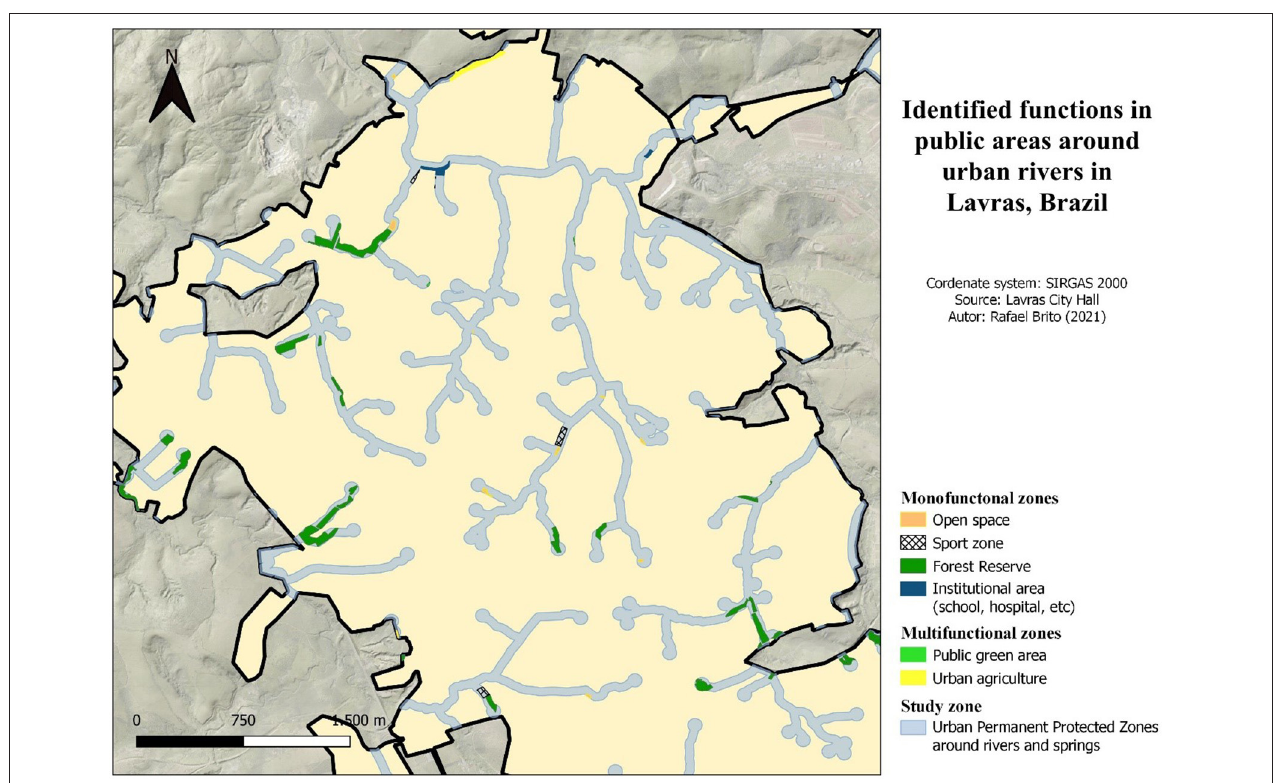
FIGURE 10 | Functions identified in public areas around Lavras watercourses. Source: Sousa R. B. et al.